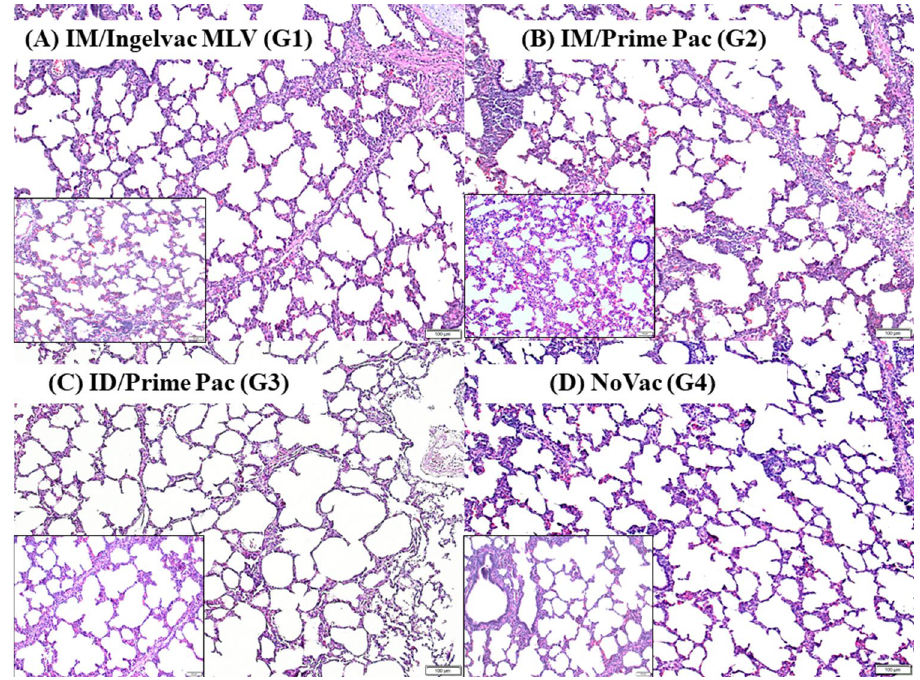
Figure 4. Microscopic lung lesion of pigs in Exp A; ( A ) IM/Ingelvac MLV (G1), ( B ) IM/Prime Pac (G2), ( C ) ID/Prime Pac (G3), and ( D ) NoVac (G4) groups, respectively. Black square pictures represented higher magnification (20X) of microscopic lung lesions for each group. H&E staining. Bars = 100 and 50 μm.